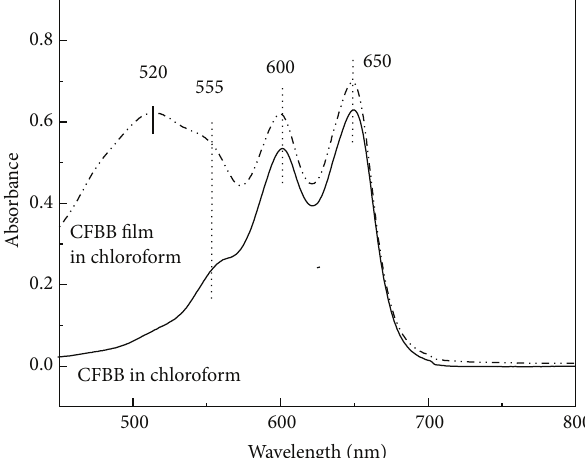
Figure 3: The UV-vis spectra of WPU-CFBB emulsion and WPU- CFBB film dissolved in chloroform. Figure 4: The UV-vis spectra of CFBB in chloroform and WPU- CFBB film dissolved in chloroform.